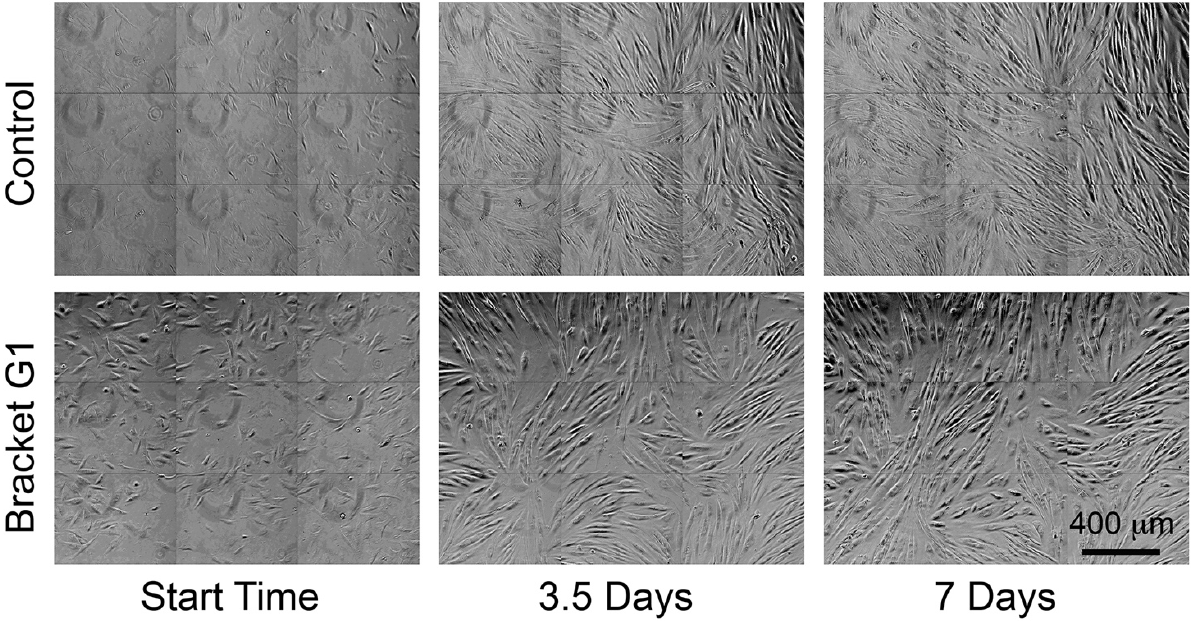
Figure 1. Photomicrographs of fibroblasts cultured in control conditions, as well as with culture medium conditioned with orthodontic brackets (G1) from the starting time through to 7 days. Increased cell culture density reflects cell division, and is lower in the bracket-conditioned medium compared with control cells. Cells in G1 conditioned medium also appeared more circular compared with controls. Movies of these cultures are provided in Supplementary Materials (SM 1). Table 2. Summary of the observed fate of tracked cells.